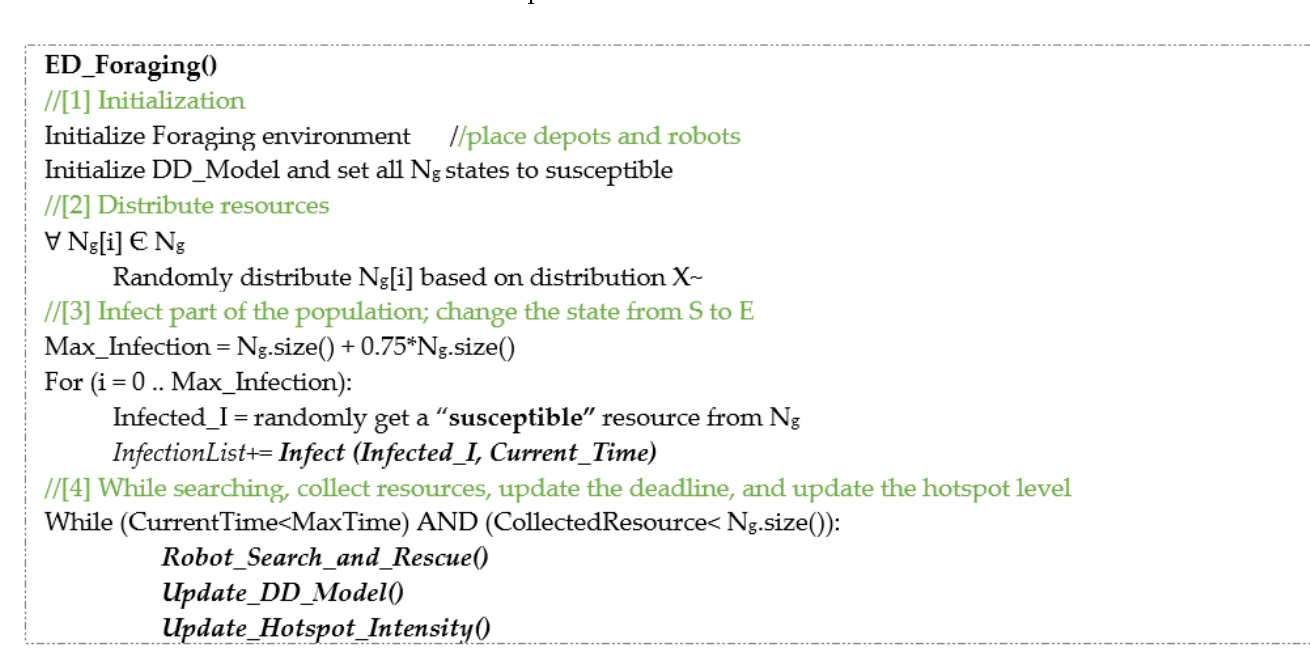
Figure 1. ED_Foraging “Main function”.